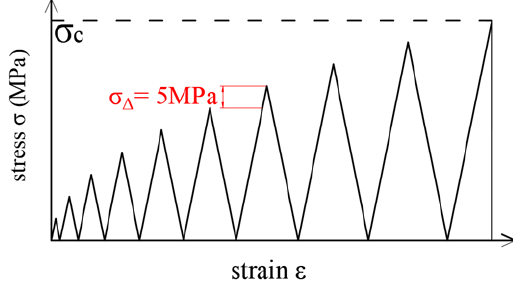
Figure 1. Loading and unloading path diagram.